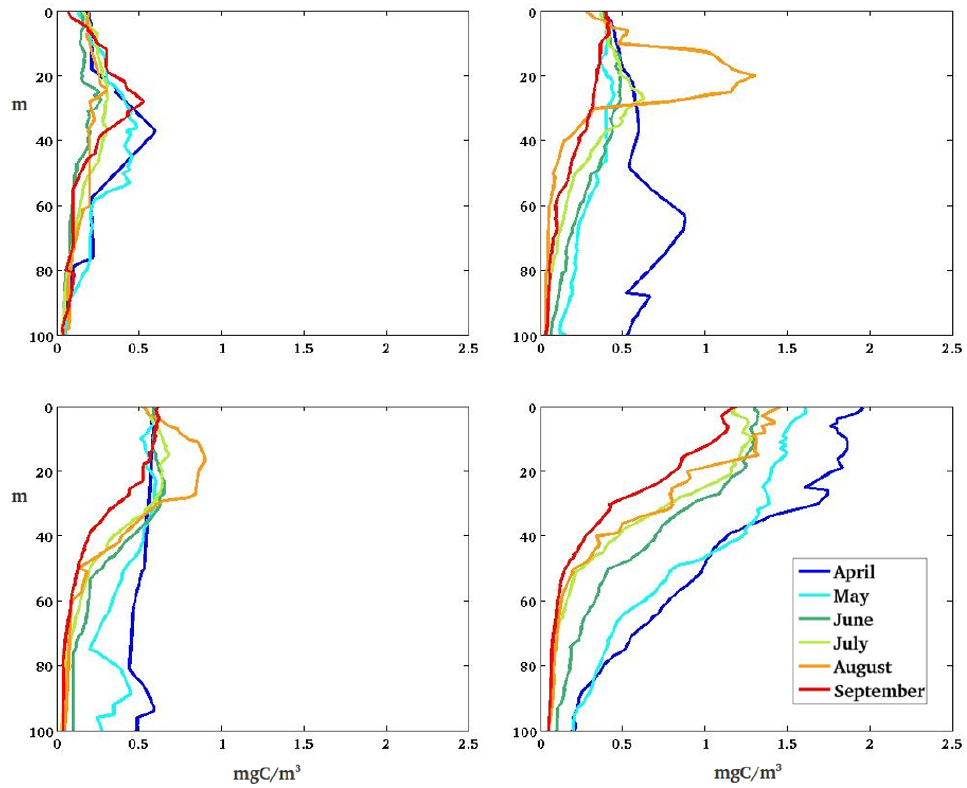
Fig. 4. Median monthly chlorophyll profiles obtained for the four ranges of mean chlorophyll within the surface layer ( C pd ,mgCm − 3 ). Ranges: (I) < 0.3; (II) 0.3–0.45; (III) 0.45–0.7; (IV) > 0.7. Data are from R/V Polarstern and Maria S. Merian cruises (unpublished), and from ARCSS-PP database,